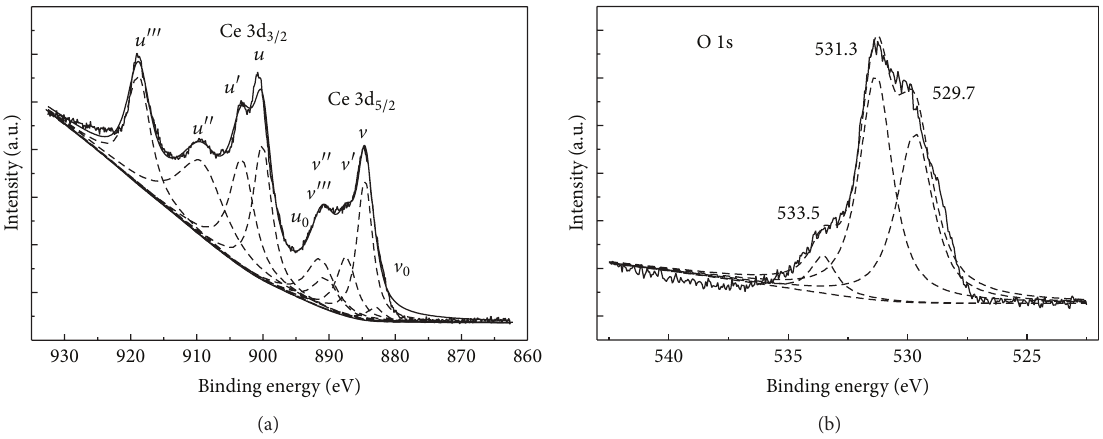
Figure 4: XPS spectra of the Ce 3d region (a) and the O 1s region (b) for the CeO 2 sample. the Co 3 O 4 loading increased from 2 wt.% to 8 wt.%, there is no distinct difference in specific surface area, average pore diameter, and total pore volume, which indicates that addition of Co 3 O 4 in the Co 3 O 4 loading range has little effect on the corresponding structure of Co 3 O 4 /CeO 2